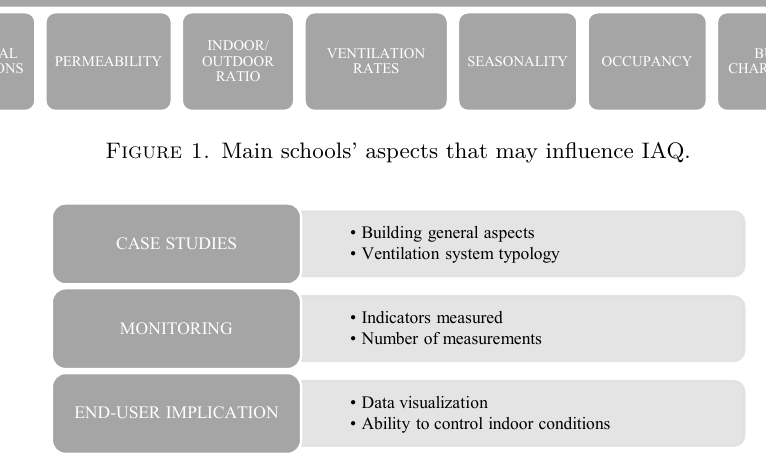
Figure 2. Characteristics analysed in the